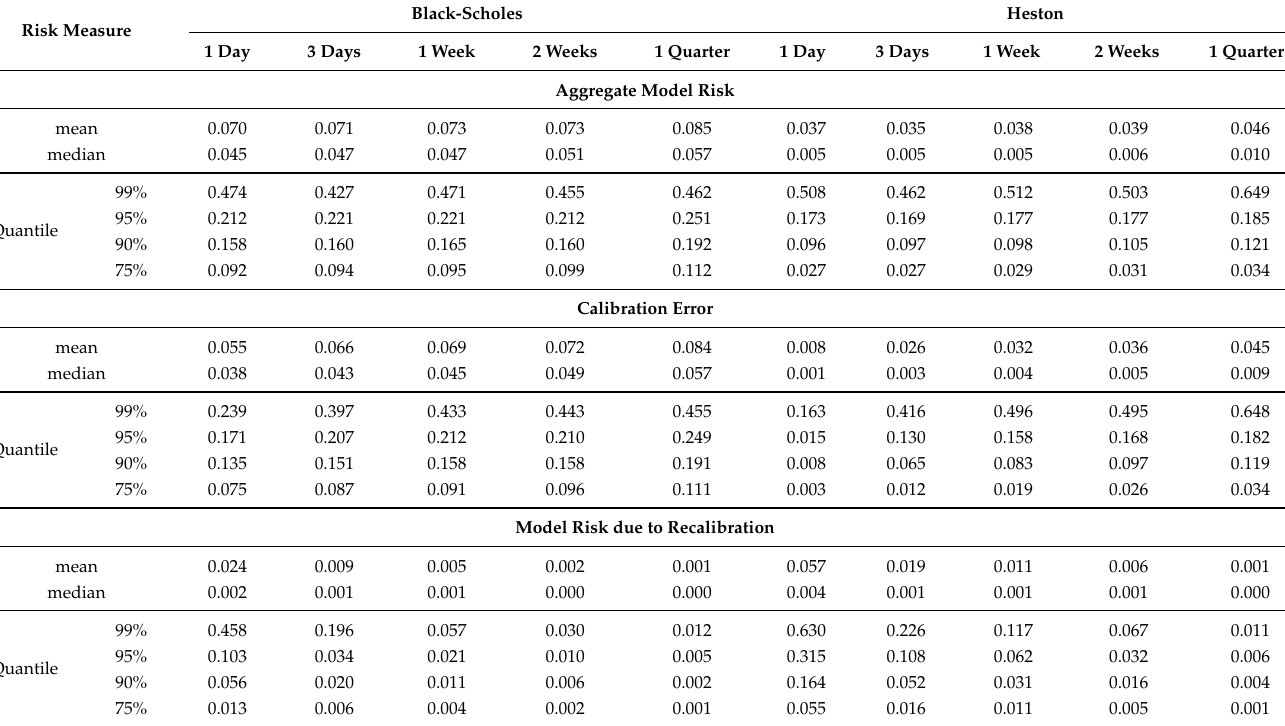
Table 1. Model risks (in terms of relative entropy) under different models and recalibration frequencies for AAPL. Black-Scholes Heston Risk Measure